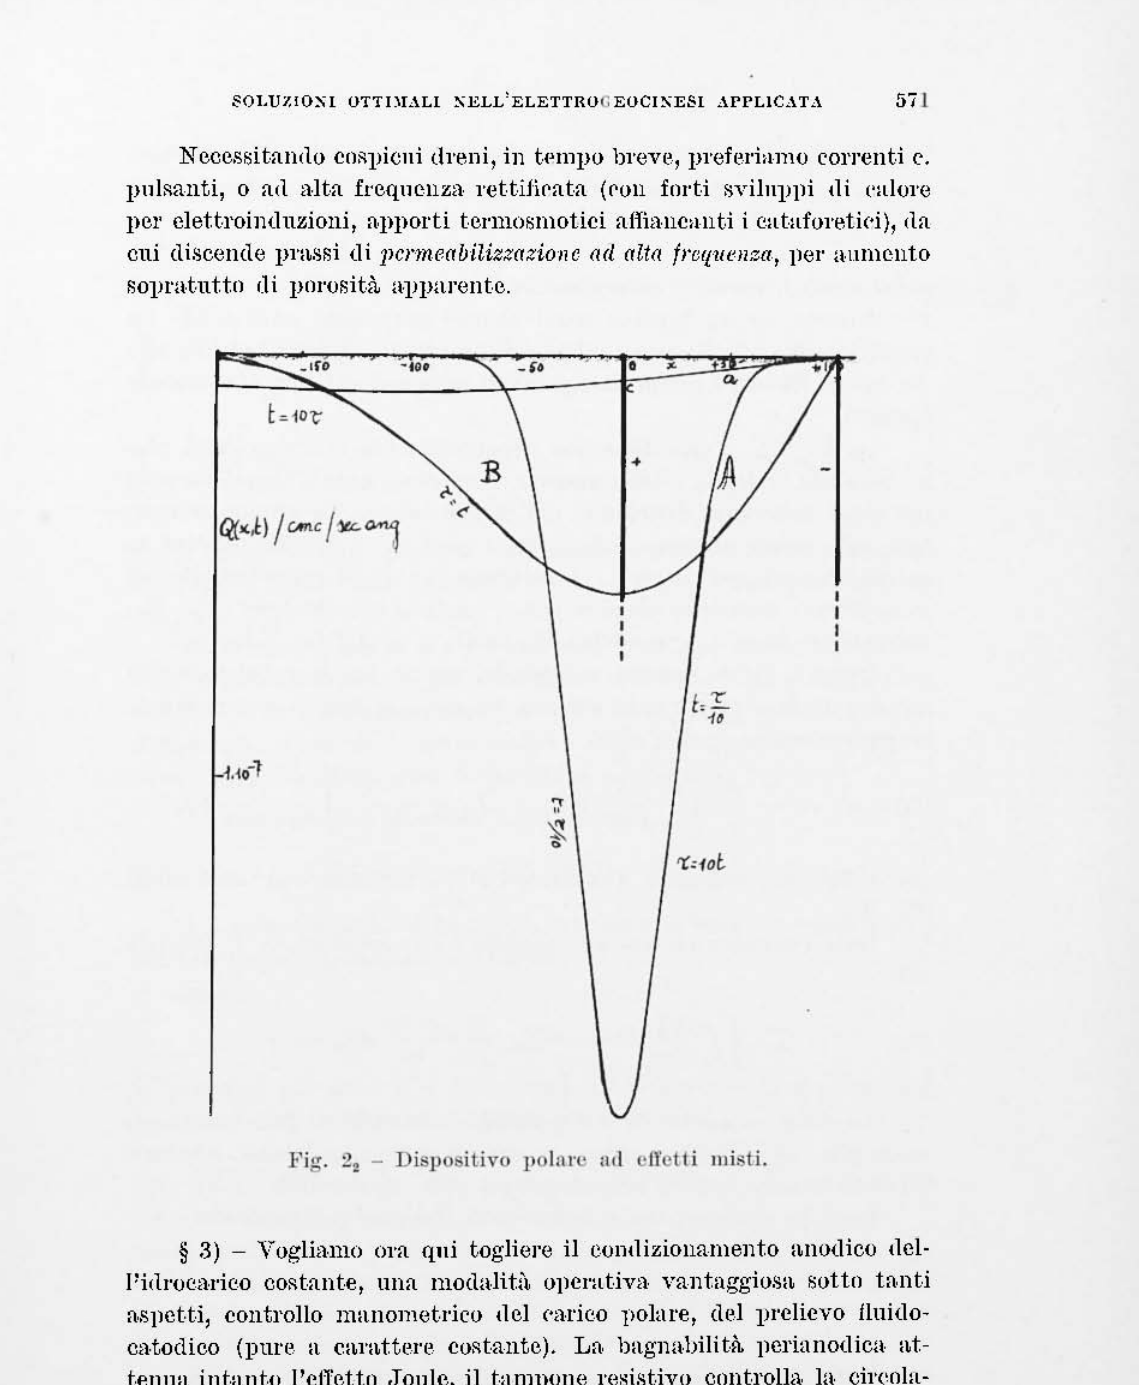
§ 3} - Vogliamo ora qui togliere il cOllllizionamento anodico Ilcl Fiarocarico cm\tante, una modalitù. o}Jerativa vantaggiosa sotto tanti aS}lctti, controllo manometrico IleI ('arico volare, del lJrclicvo fluido catodico (pure a carattere cOf\tante). La bagnahilitA }lcrianodica at t.enua int.ant.o l'cfIetto ,Toule, il t.ampone re8istivo controlla, la CÌr('ola zionc aeUa c.c.; il livello costante idrico nel t.ubo metallico anoaico